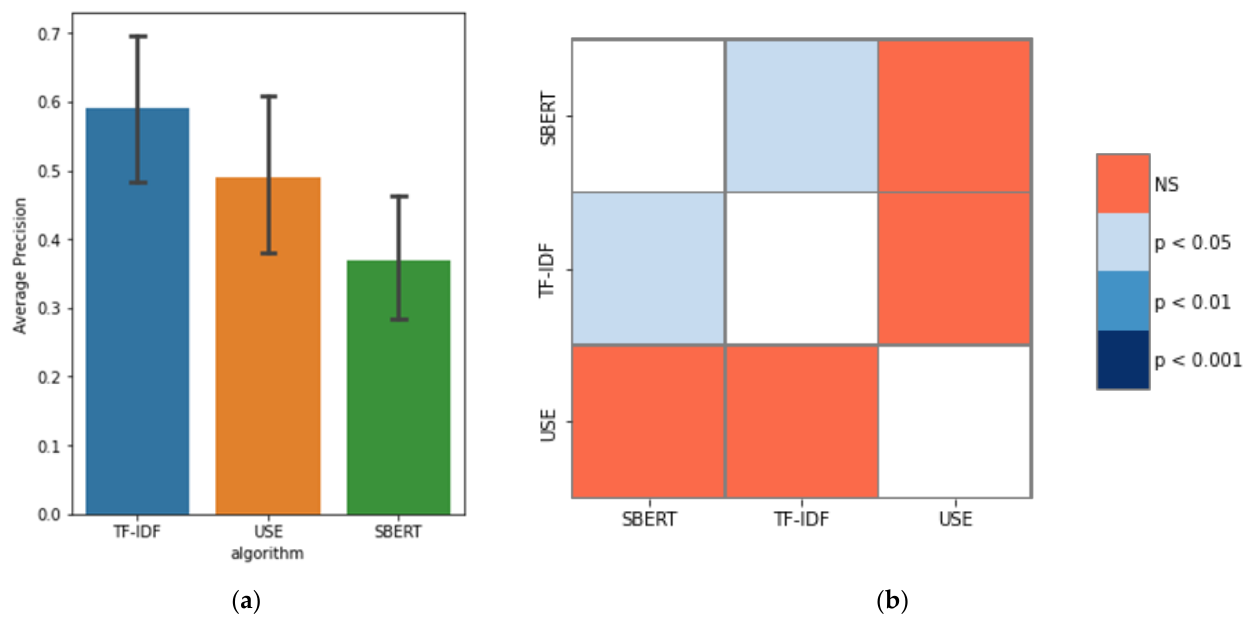
Figure 15. ( a ) Plotting average precision data; ( b ) heatmap of the results of the Kruskal – Wallis test. Answer RQ 2.